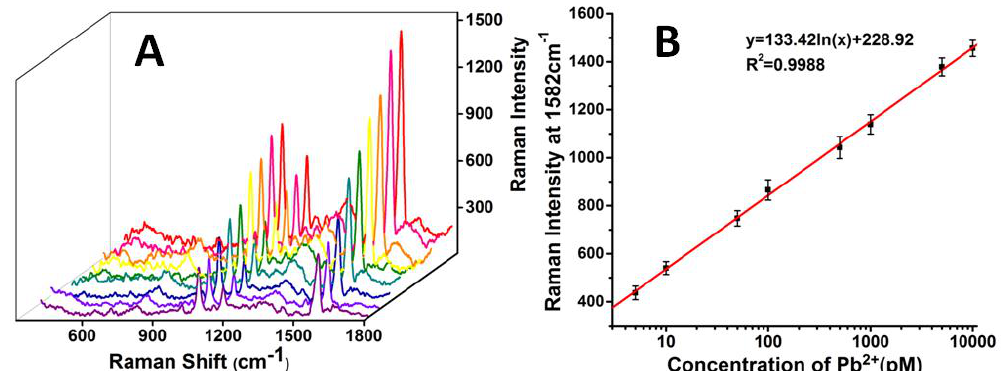
Figure 4. ( A ) Surface-enhanced Raman scattering (SERS) spectra of 4-ATP in the presence of Pb 2+ at different concentrations, from front to back: 0, 0.005, 0.01, 0.05, 0.1, 0.5, 1, 5, 10 nm. ( B ) Linear plot of intensity of the 1582 cm − 1 peak versus the Pb 2+ concentration.